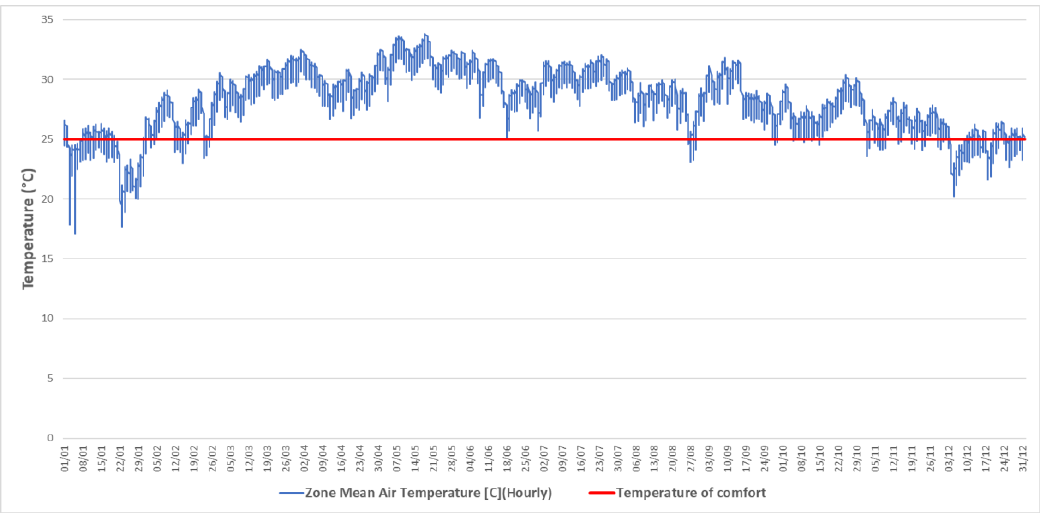
Figure 16. Annual indoor temperatures considering an urban convective coefficient of 52.80 W/m 2 K.